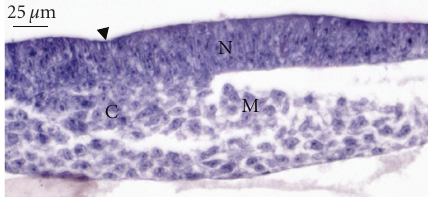
Figure 5: Section through the mesoblast mantle (M) and the more lateral coelomo-vascular area (area vasculosa) of a chicken hemi- embryo after one day of culture. E, epiblast; B, blood islands domed by rudimentary coelomic vesicles (C); JE, junctional endoblast; SE, sickle endoblast; G, intraembryonic cavity. Hematoxylin-eosin. Bar = 15 μ m.